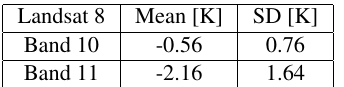
Table 4: Mean error and standard deviation for each band of Landsat